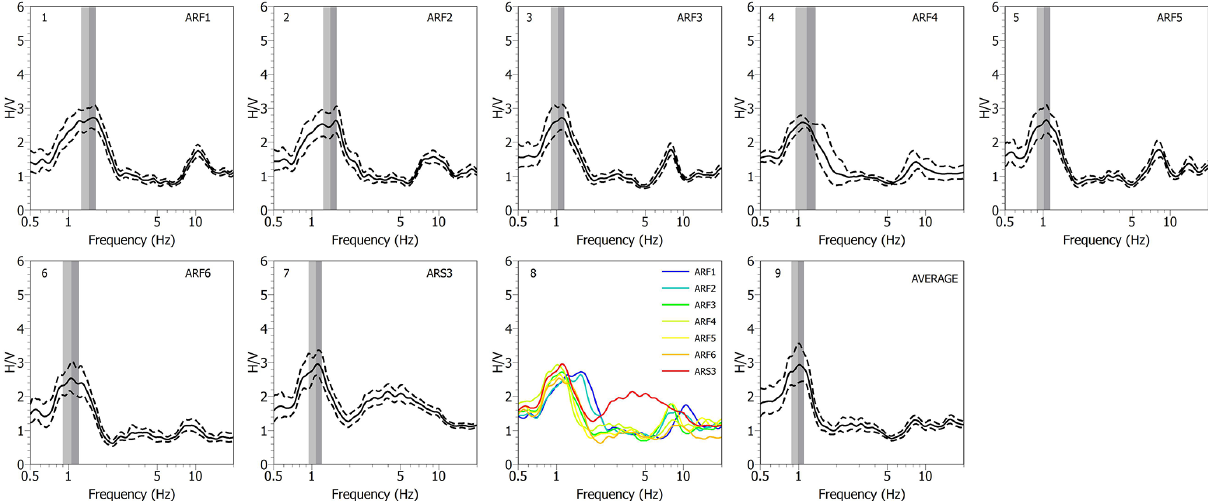
Figure 3. Panels from (1) to (6) are the H/V spectral ratios of the six array underground stations (ARF*) and panel (7) is the H/V spectral ratio of the surface station ARS3. The black continuous line is the mean of the H/V spectral ratio. The dashed black lines are the standard deviations. The grey band identifies the f 0 frequency. In panel (8) the colors from blue to orange are the mean H/V of the six underground stations and the red one is the mean of the surface station ARS3. In the panel 9 the array averaged H/V is shown.